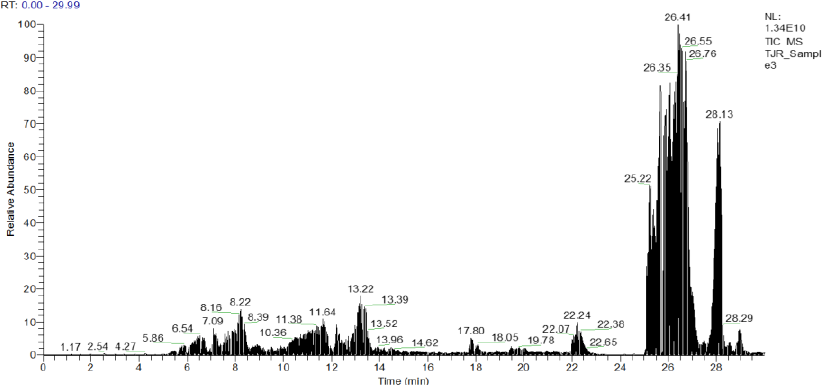
Figure 2. Total ion chromatogram of the pH 4 fraction of R. communis seed protein hydrolysate analysis obtained using high-performance liquid chromatography coupled with high-resolution mass spectrometry.